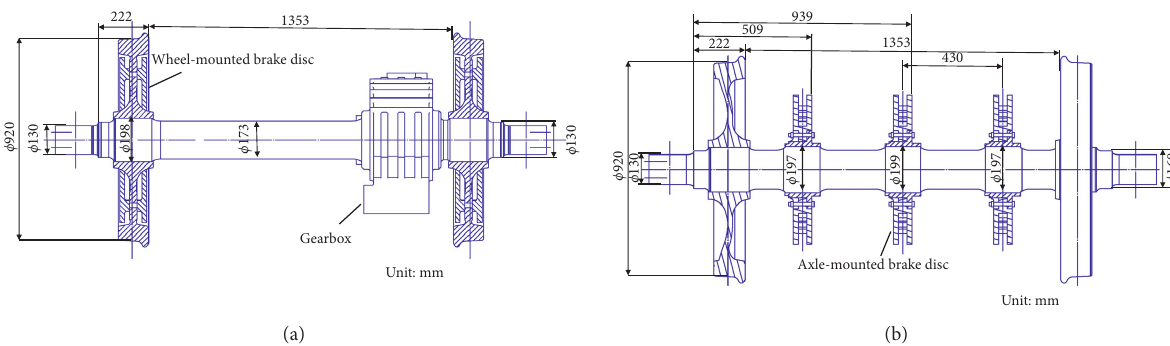
Figure 2: The wheelset size diagrams of high-speed trains: (a) the power wheelset, (b) the trailer wheelset.